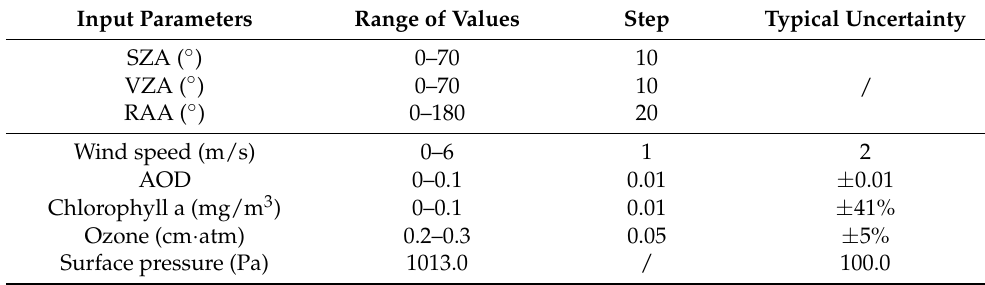
Table 1. The parameters setting for the error budget of the Rayleigh scattering method. Input Parameters Range of Values Step Typical Uncertainty SZA ( ◦ ) 0–70 10 /VZA ( ◦ ) Wind speed (m/s)